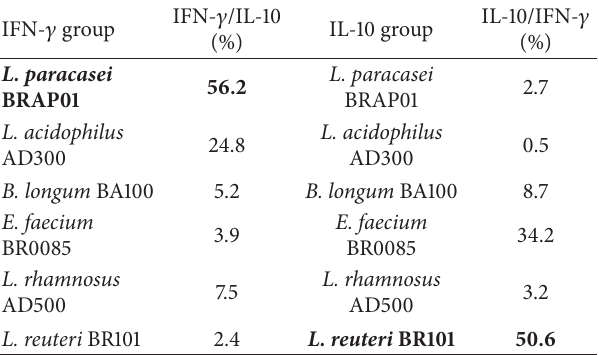
Table 1: Representative results of microfluidic assays in IFN- 𝛾 and IL-10